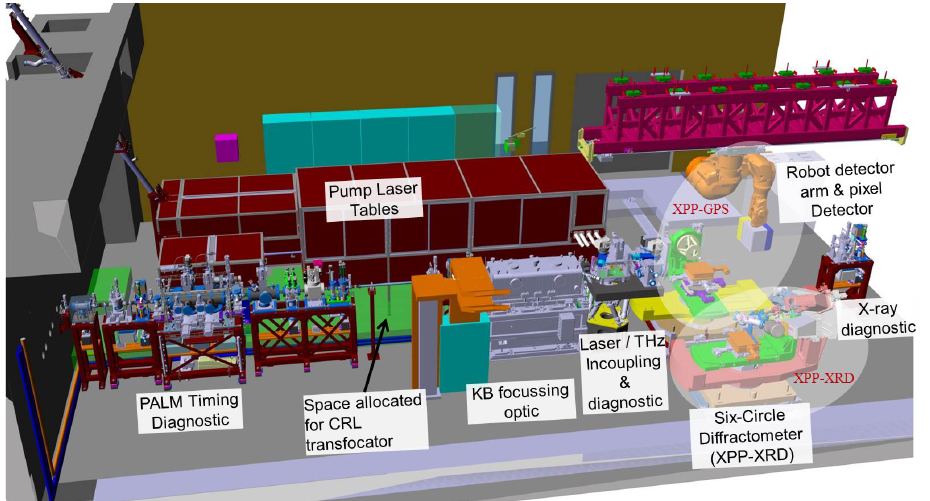
Figure 18. The Experimental Station Bernina X-ray hutch. The various components located in the hutch are